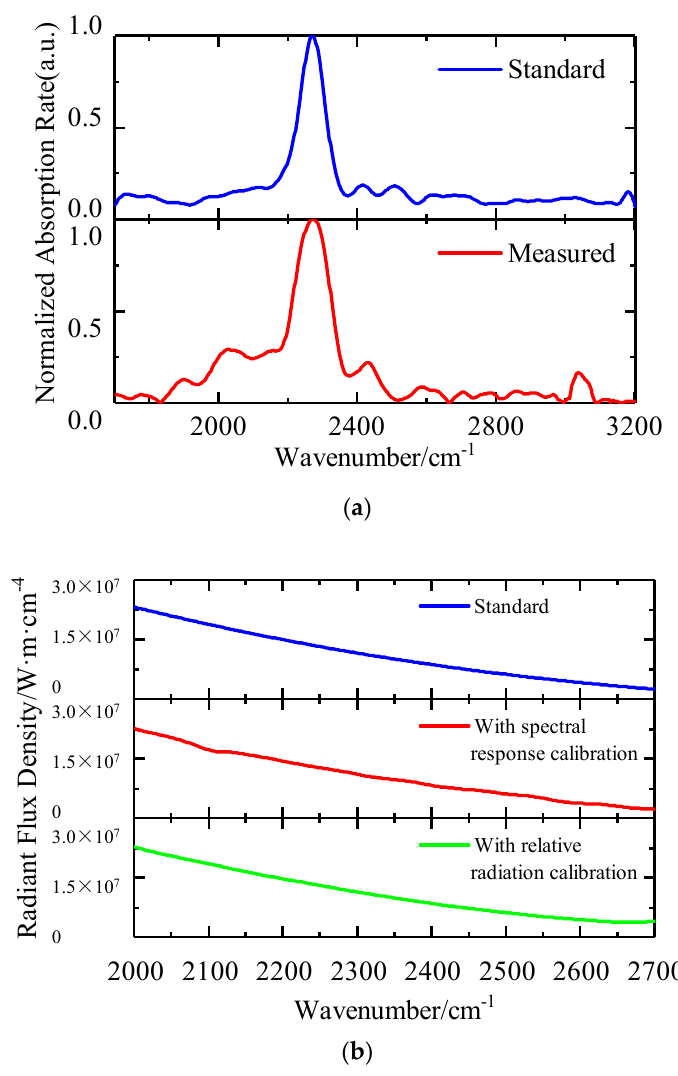
Figure 17. ( a ) Theoretical and measured spectra of acetonitrile. ( b ) The radiation intensity of blackbody at 333 K.